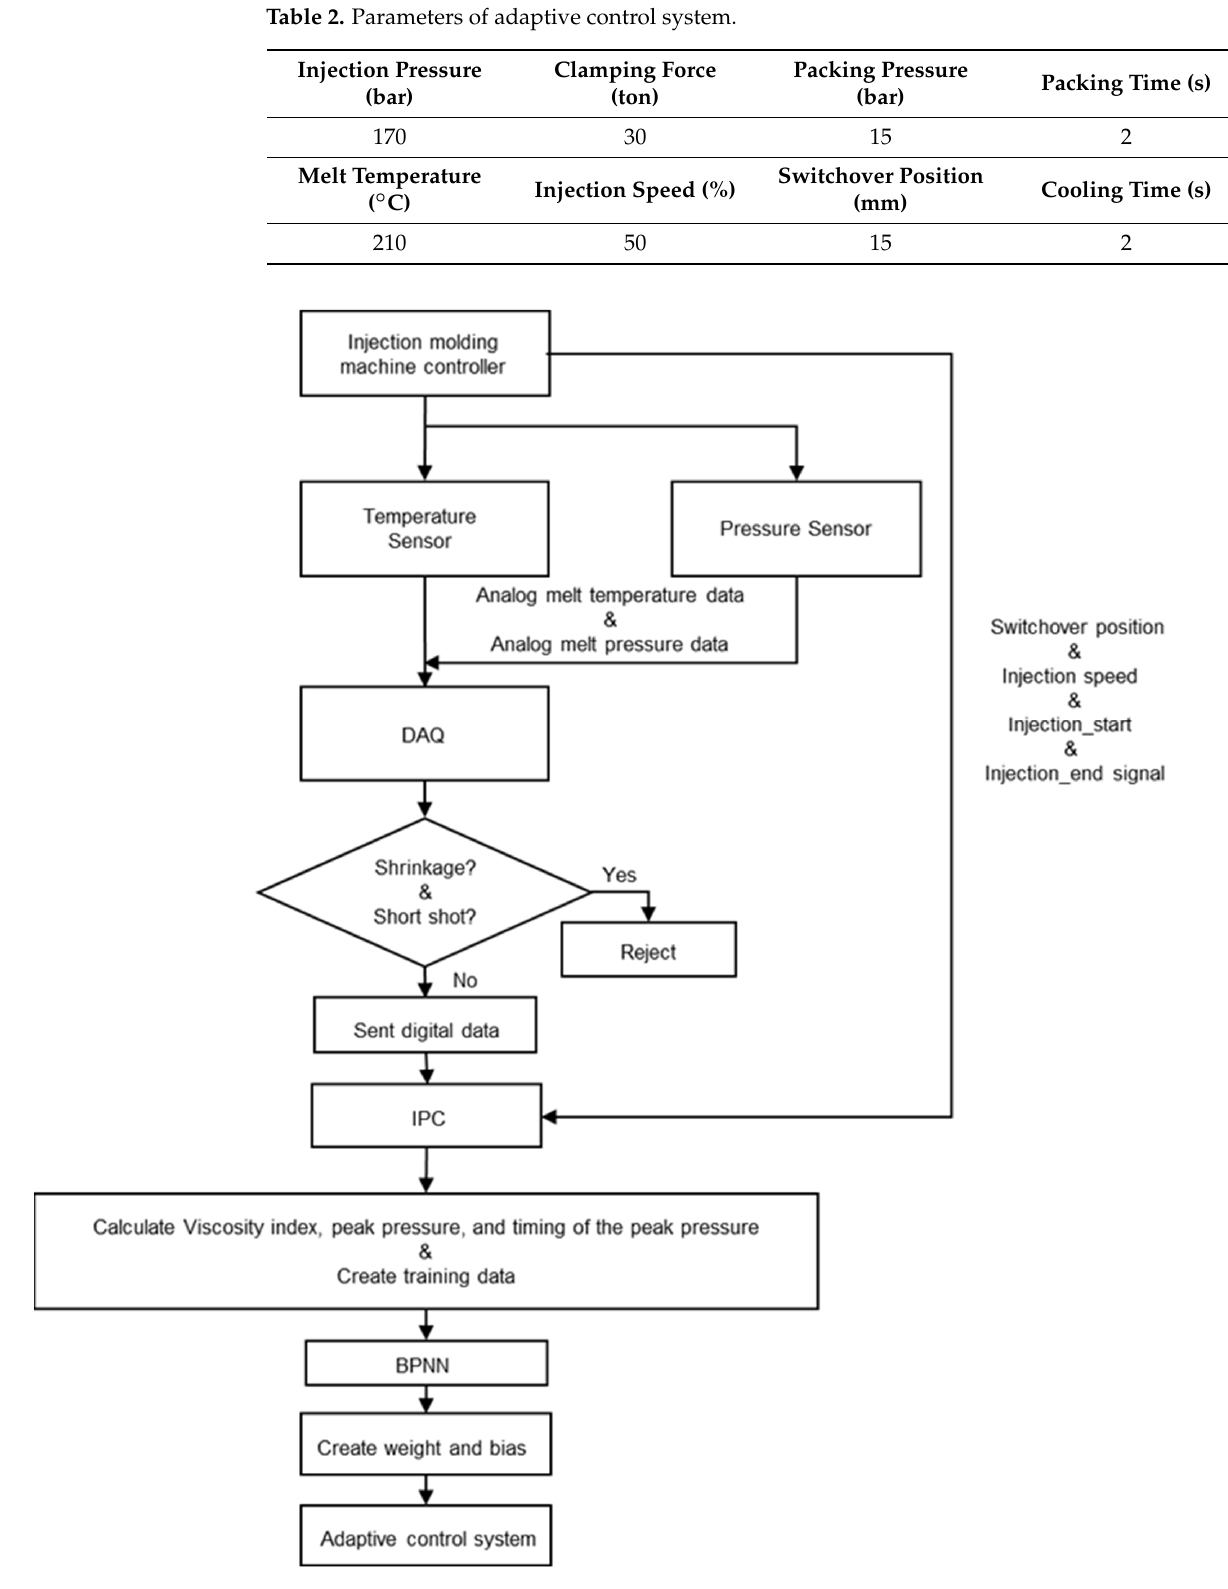
Figure 7. The establishment process of BPNN model .